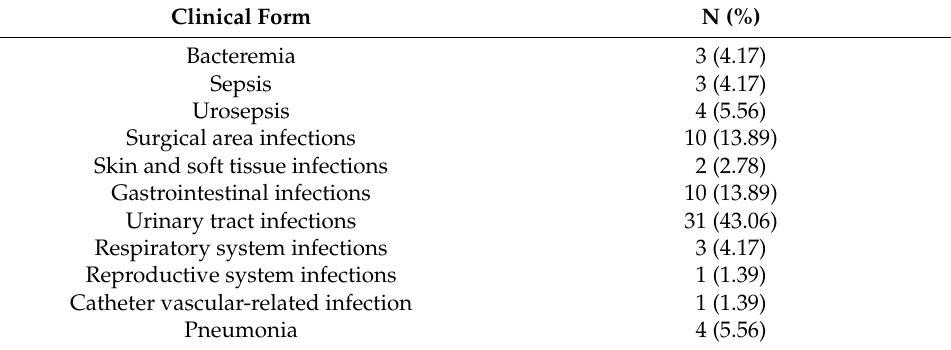
Table 7. Clinical form of nosocomial infections.